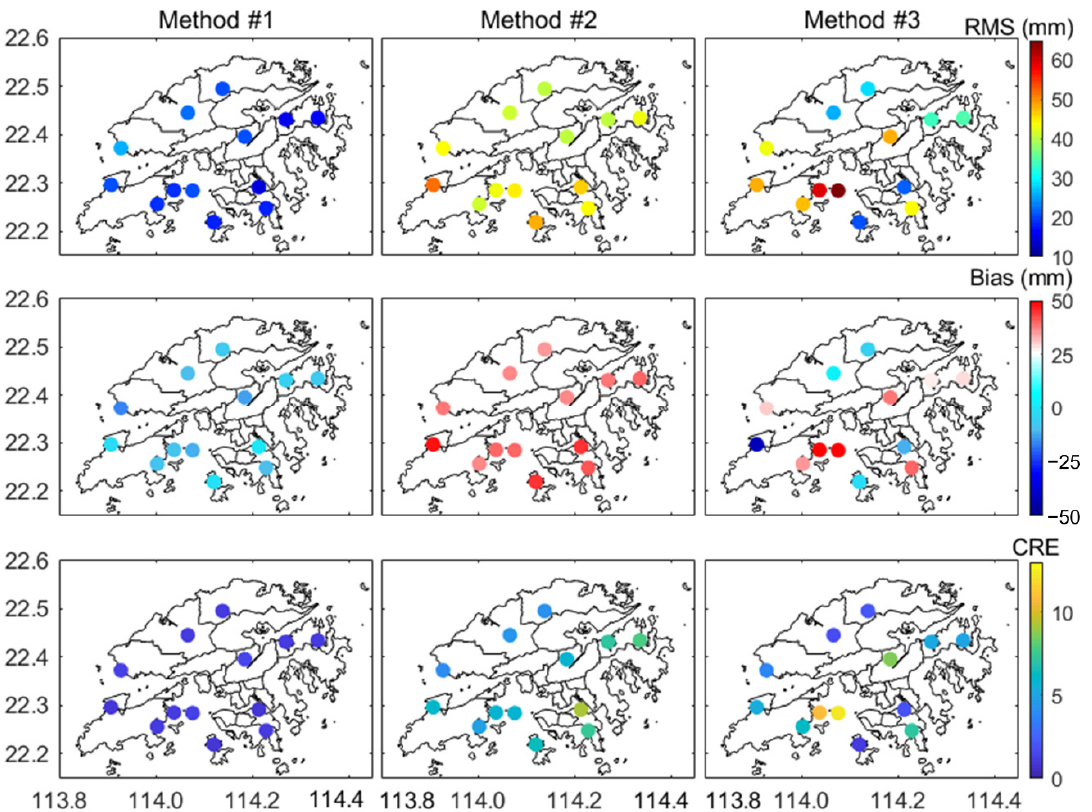
Figure 5. Map showing root mean square error (RMSE), bias, and compound relative error (CRE) at the 13 GNSS sites for the three methods.